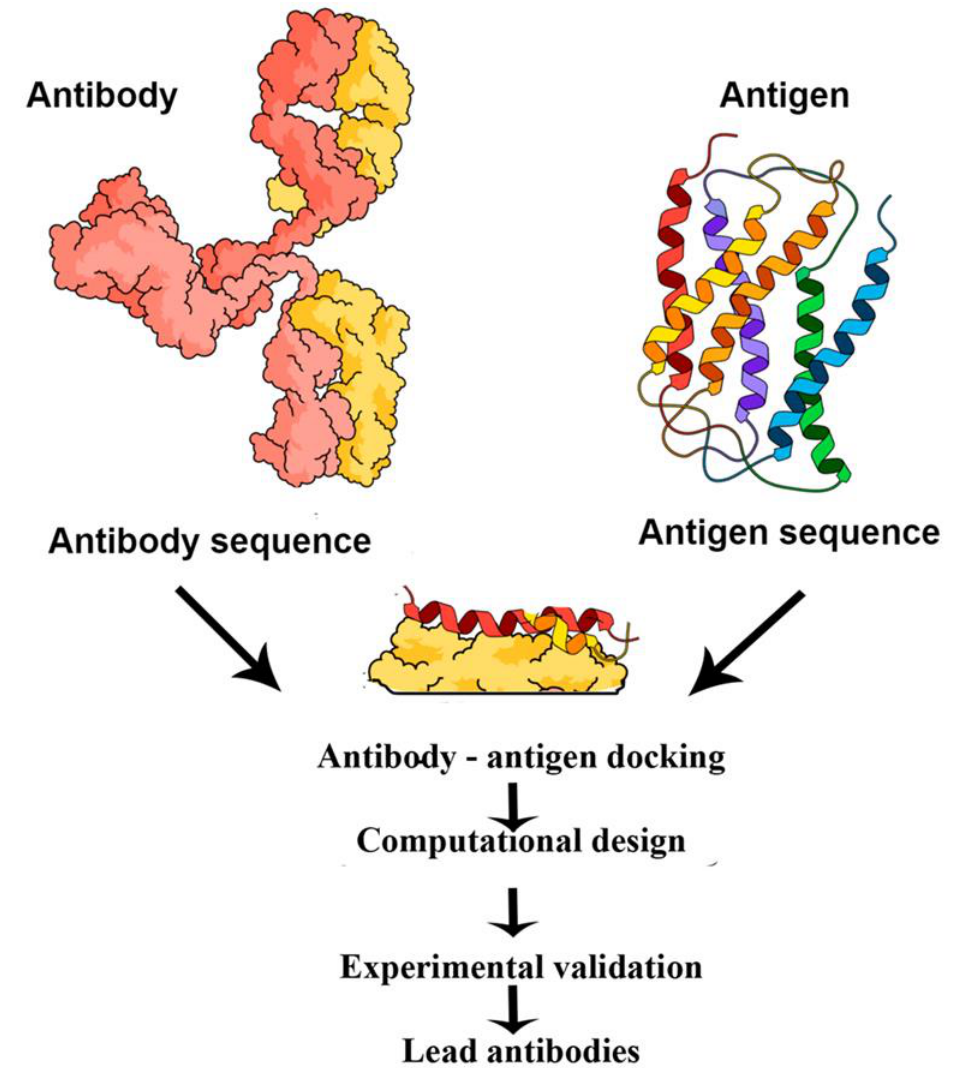
Figure 11. Block diagram for computational modeling in antibody-antigen docking.